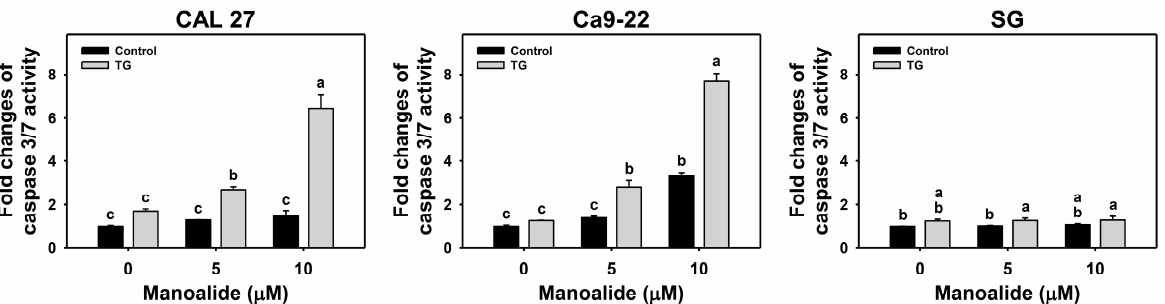
Figure 5. ER stress inducer (TG) enhances the caspase 3/7 activation of manoalide on oral cancer cells. Cells were co-treated with TG (0.01 µ M) and manoalide (0, 5, and 10 µ M) for 24 h. Data, means ± SDs ( n = 3). Multiple comparisons were analyzed for the same cell lines. Treatments marked with different notes indicate a significant difference ( p < 0.05 to